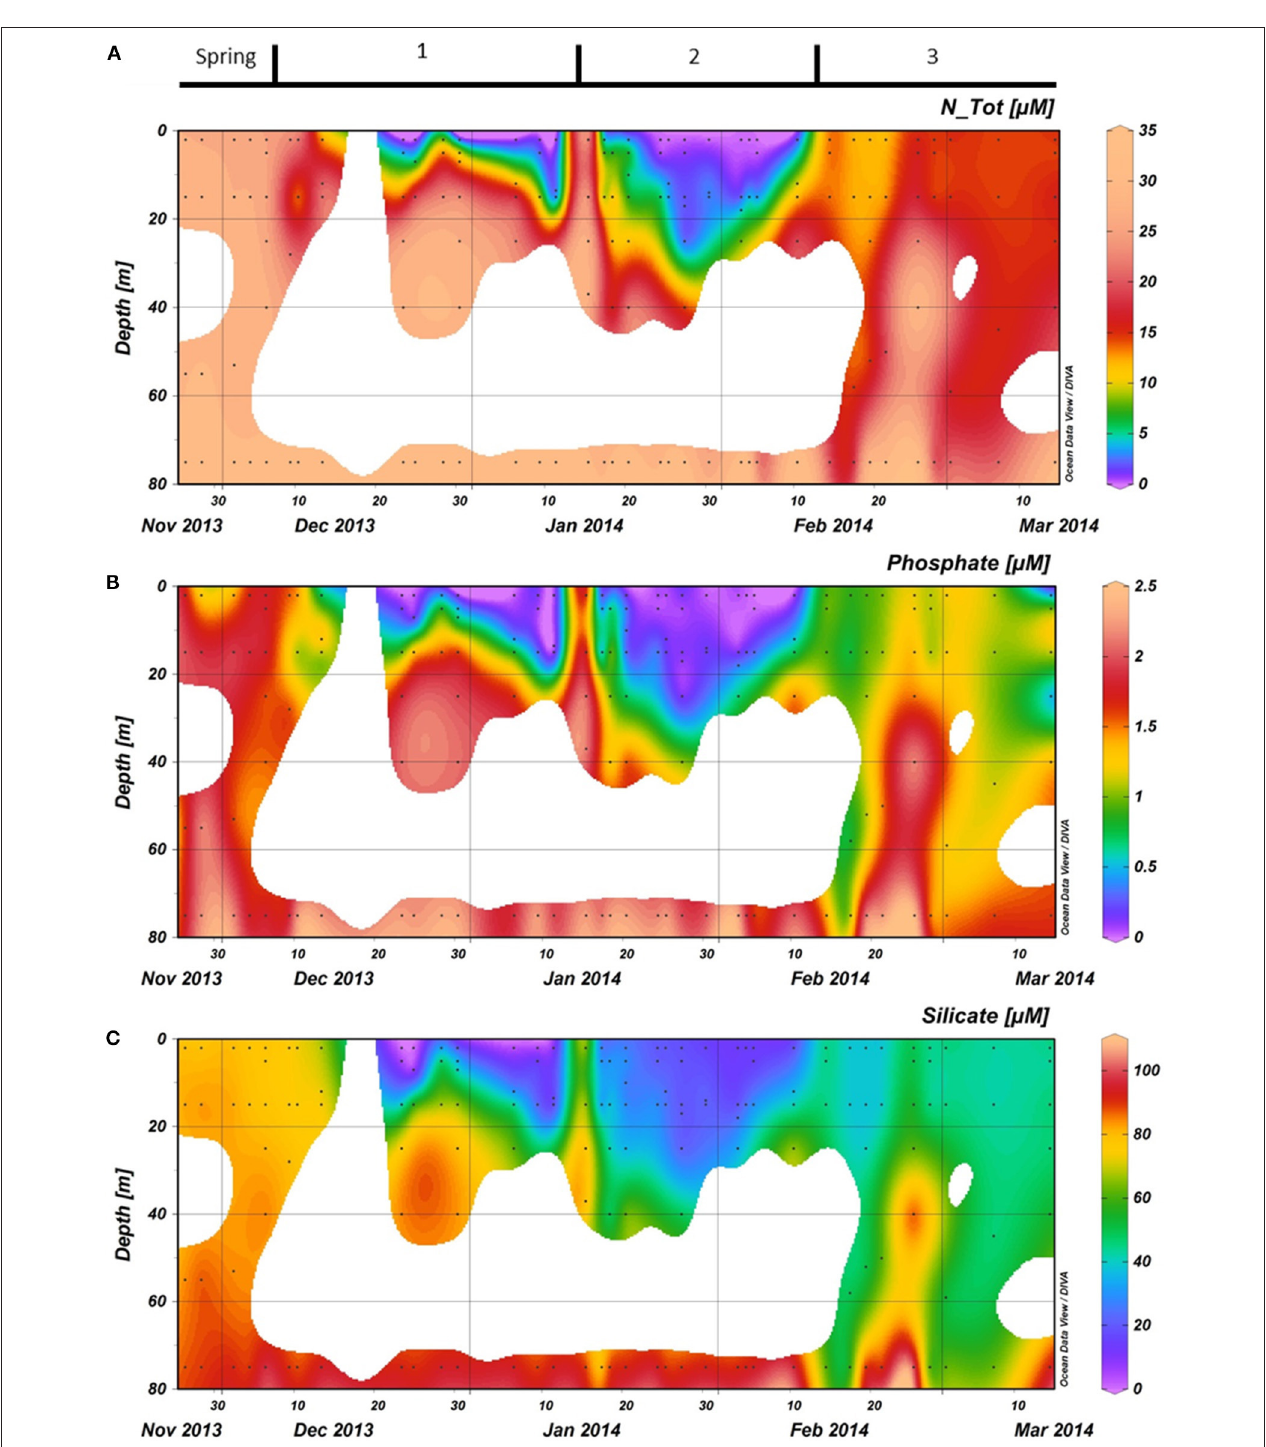
FIGURE 5 | (A) : Total nitrogen (nitrate + nitrite), (B) : Phosphate, and (C) : Silicate concentrations in the water column at the RaTS site. Black dots illustrate the sampling depths. Period 1 starts on December 6th, period 2 on January 15th and period 3 on February 10th.